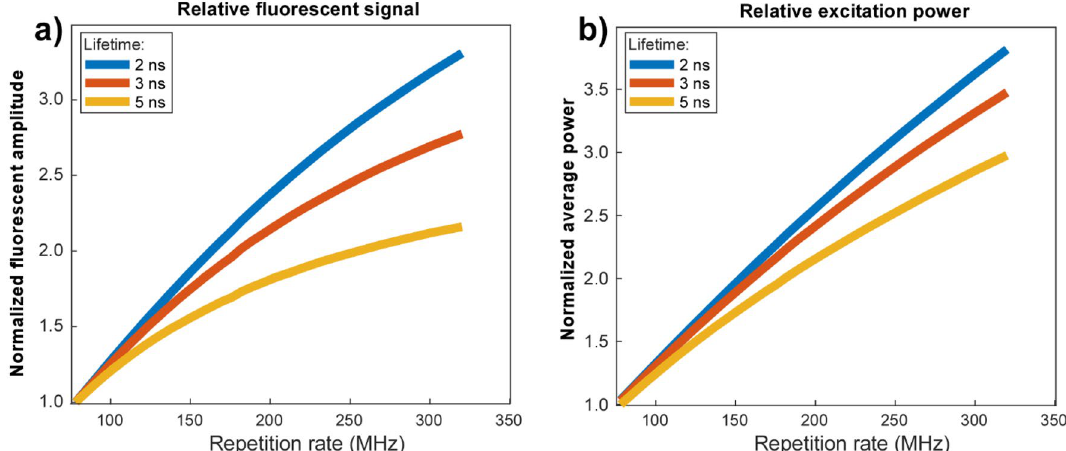
Figure 10. Fluorescent yield of fluorophores over laser repetition rate. Relative fluorescent yield per second ( a ) and average excitation power required ( b ) to keep 10% of fluorophores in a pixel excited in steady state for 3 different single exponential fluorescent lifetimes. Amplitudes are normalized with 78 MHz equal to 1.0. For shorter lifetimes, both fluorescent yield and excitation power are nearly linear, with a fourfold increase in repetition rate yielding a 3.3-fold increase in fluorescence at 3.8 times the average power. For longer lifetimes, fluorophores do not have time to fully relax between excitations, and pulse energy must be decreased to keep a constant 10% of fluorophores excited, resulting in both lower fluorescent yield per time and lower maximum average excitation